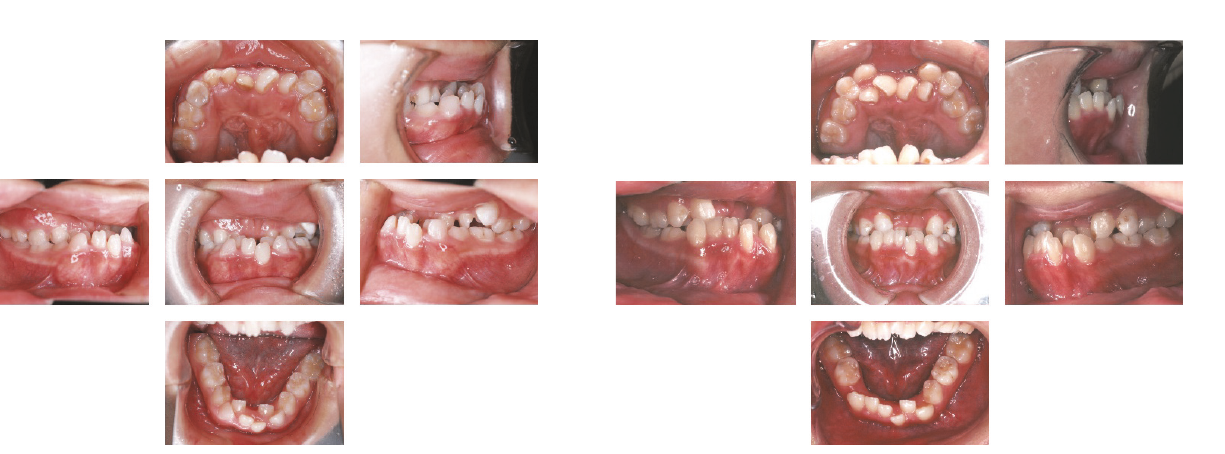
Figure 3: Intraoral photographs during the observation period and after the facemask treatment (13 years and 1